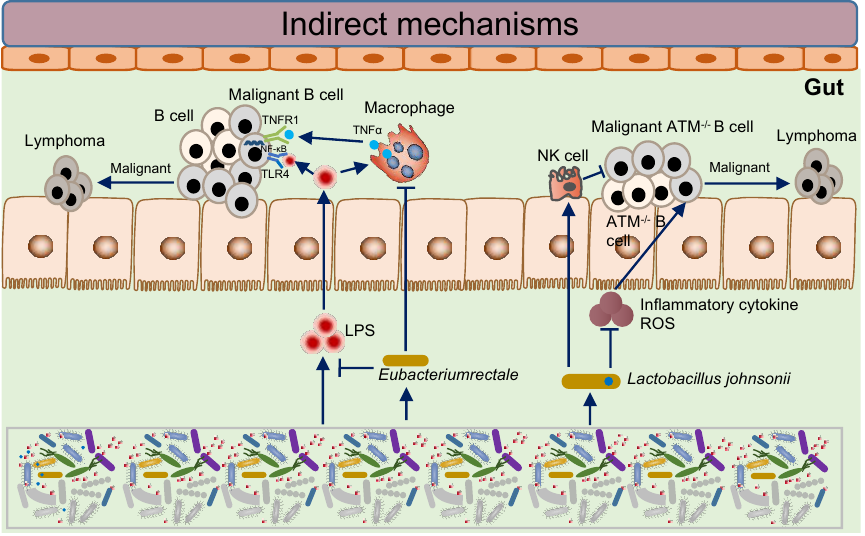
Figure 2. The mechanism of intestinal microbes affecting the initiation and progression of